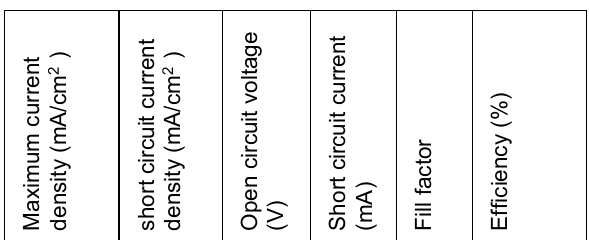
Table 9. Performance parameters of sample